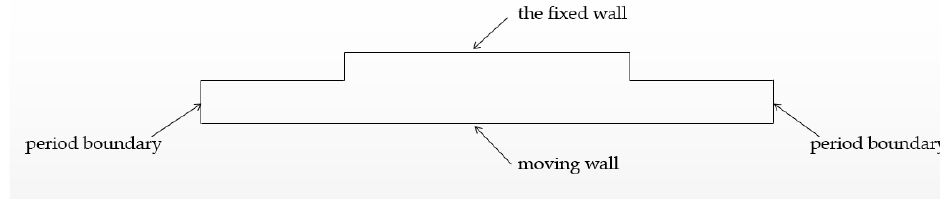
Figure 4. Fluid Model